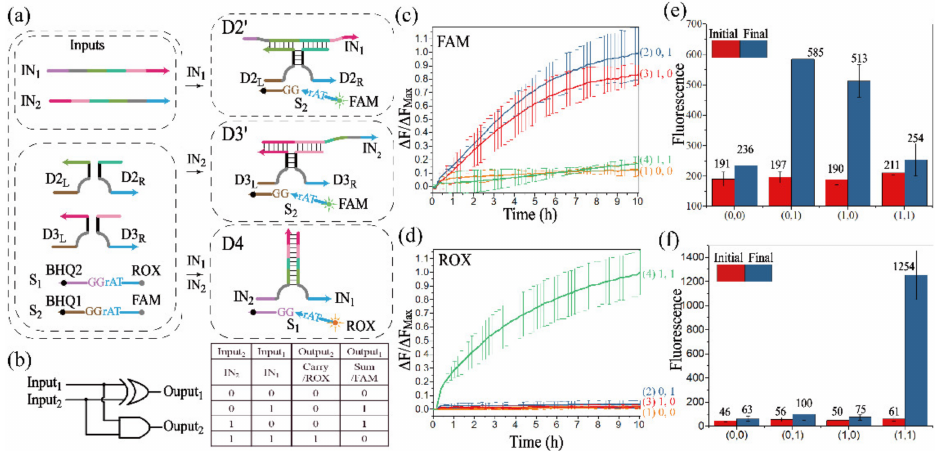
Figure 3. ( a ) Schematic diagram of the half-adder. ( b ) Truth table and logical operations of the half-adder. Signals of SUM bit ( c ) and CARRY bit ( d ) represented by the time-dependent normalized fluorescence curves of FAM and ROX. The fluorescence intensities are recorded every 10 min. (1) No input is added; (2) IN 1 is added; (3) IN 2 is added; (4) IN 1 and IN 2 are both added. The real fluorescence of SUM bit ( e ) and CARRY bit. ( f ) The initial state: red columns, and the final state: blue columns. All data represent the average of three replicates. Error bars represent one standard deviation from triplicate analyses, which is available for all the fluorescence assays of logic circuits in this